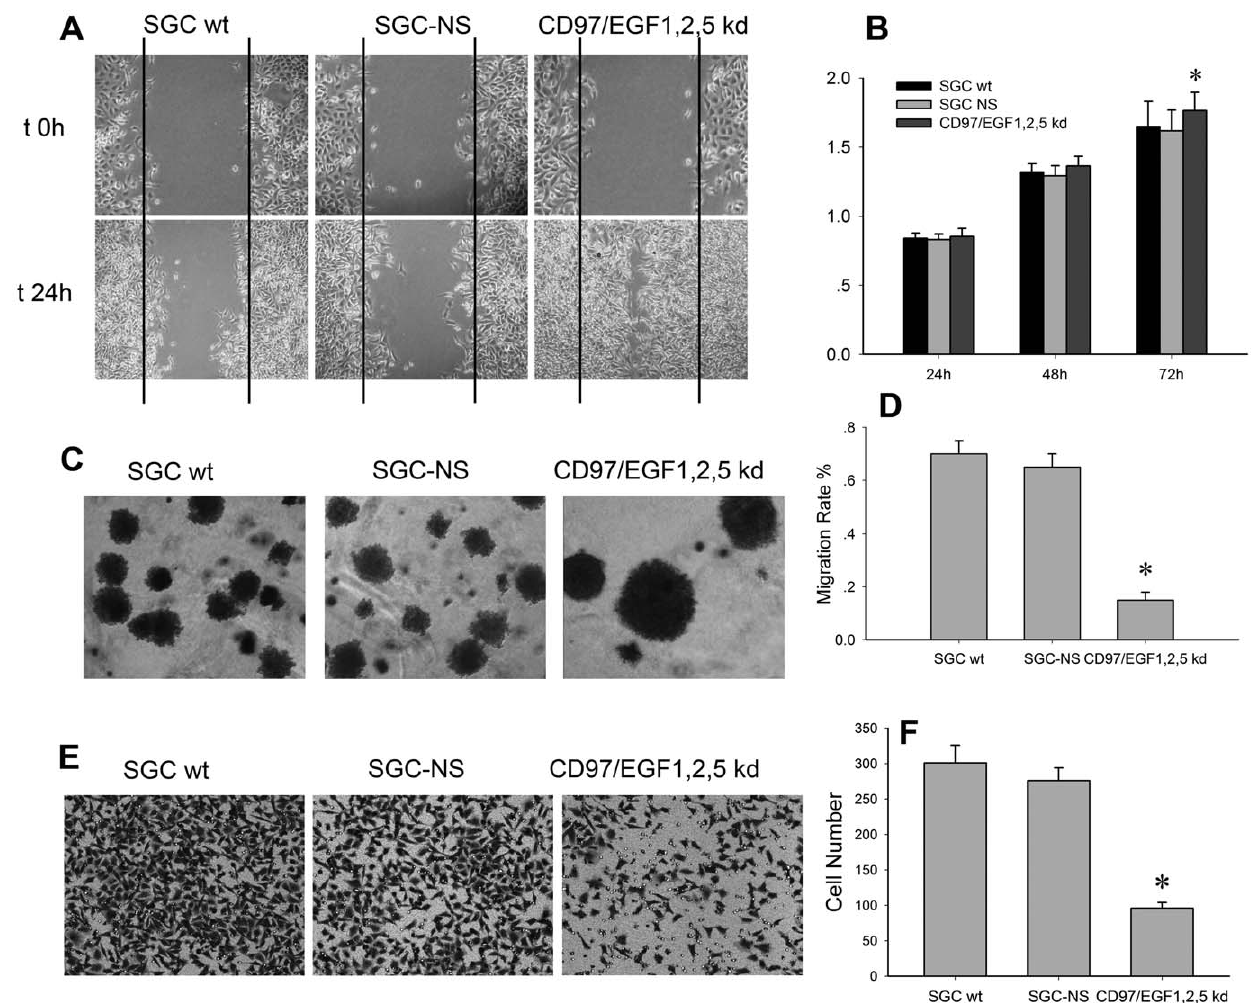
Figure 2. Effect of CD97 small isoform on proliferation, migration and invasion of human gastric cancer cells. The migration ability of SGCwt cells, SGC-NS and CD97/EGF1,2,5 groups were assessed by scratch-wound assay (A) and soft agar (C), which showed bigger size colonies and aggregated type of growth. The migration rate (D) was calculated as the proportion of the mean distance between both borderlines caused by scratching to the distance that remained cell-free after re-growing (*p , 0.01). (B) MTT assay revealed the proliferative ability was significantly higher in CD97/EGF1,2,5 kd group as compared to the controls (*p , 0.01). (E,F) Invasive assay revealed the number of penetrated CD97 small isoform kd clones was significantly decreased as compared to the control (*p ,